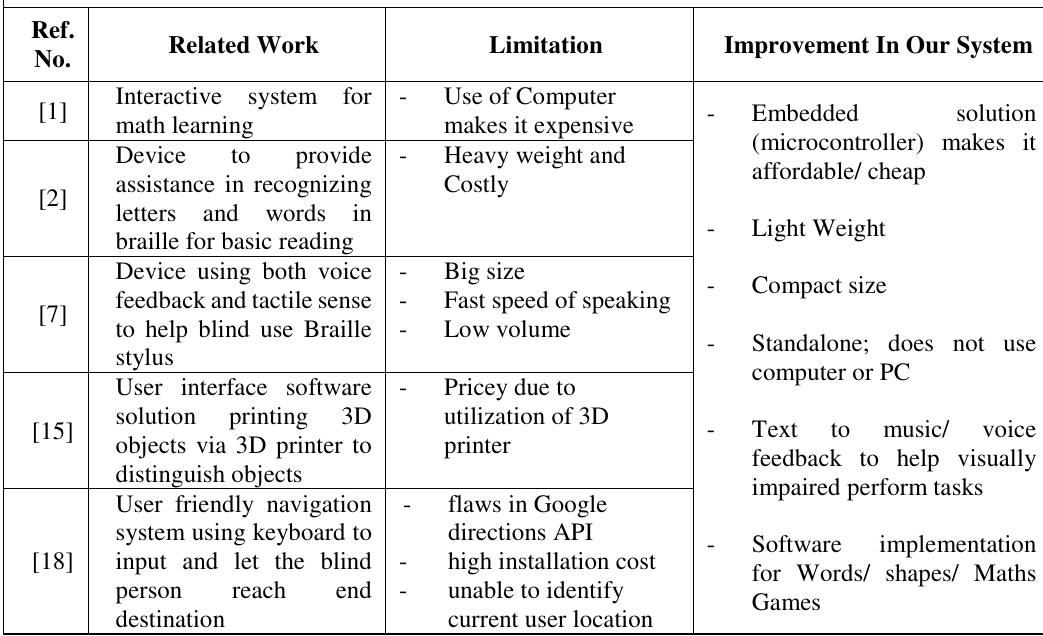
Table 1: Comparison to the State-of-the-art